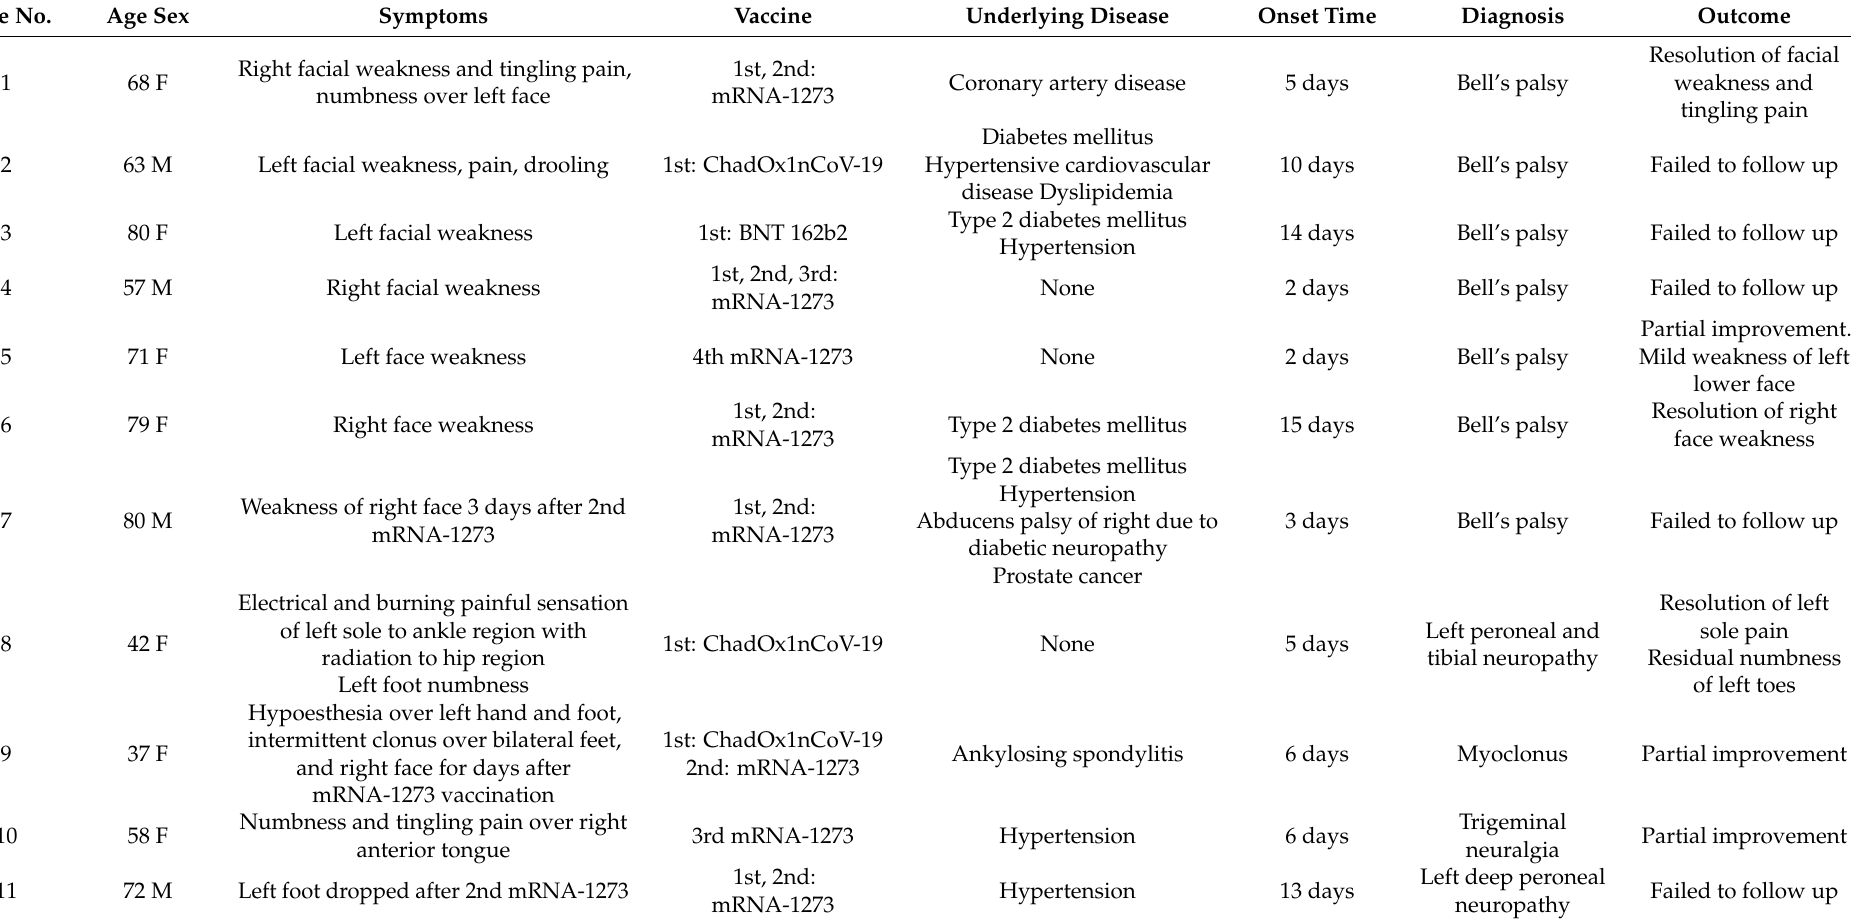
Table 1. Patients with neurological complications after receiving COVID-19